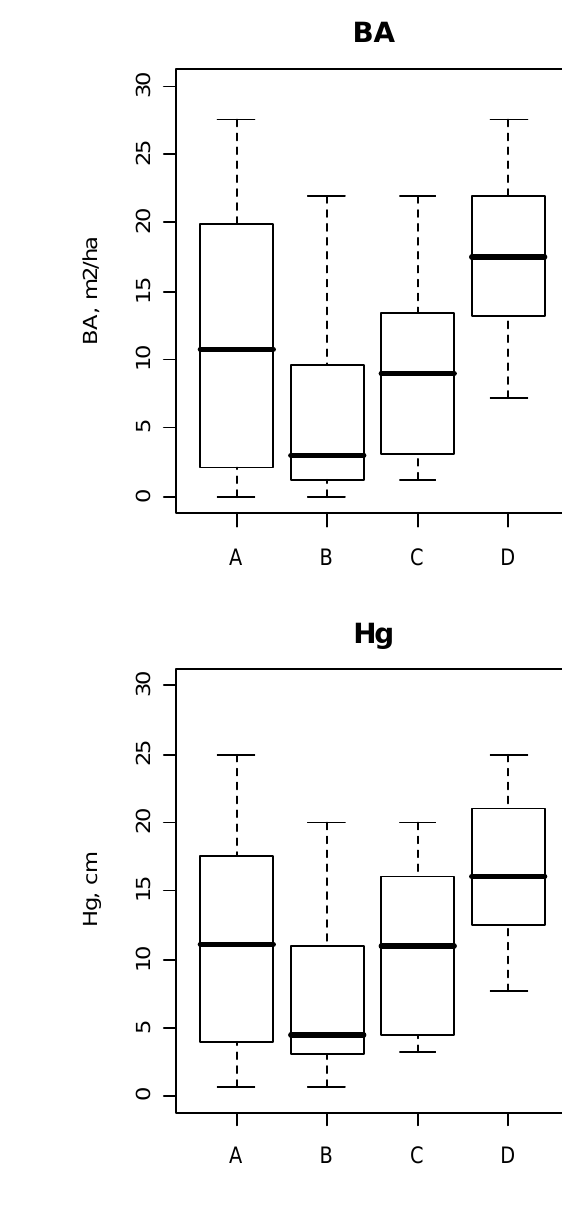
Figure 1. Variation in stand characteristics within the forest properties: A (having an even development class distribution), B (sapling stands), C (young thinning stands) and D (mature stands). Top left: age; top right: basal area (BA); bottom left: mean diameter (Dg); and bottom right: mean height